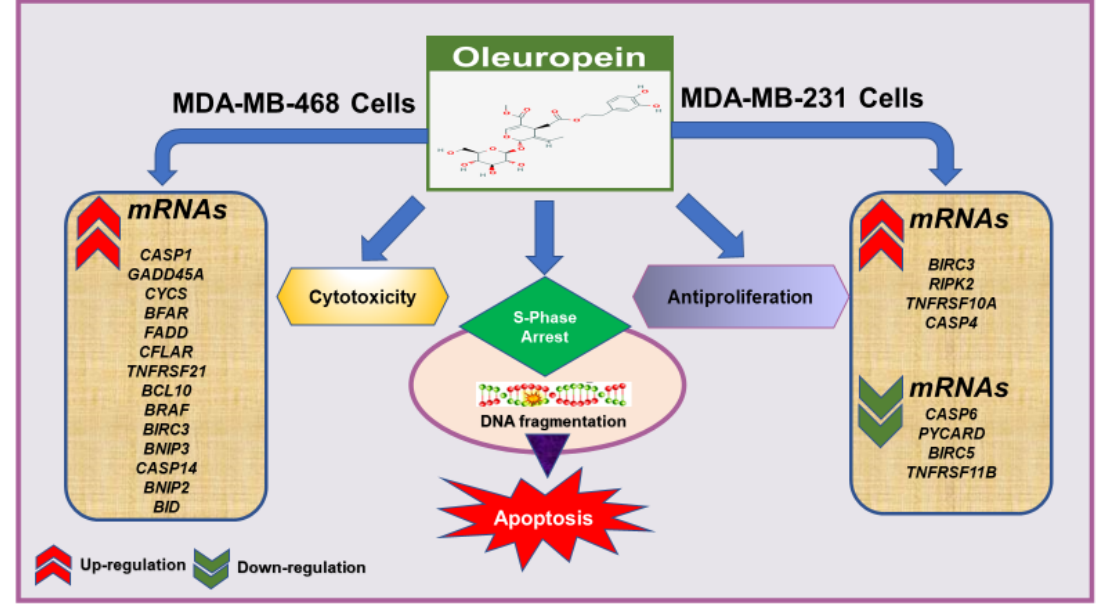
Figure 6. The e ff ect of OL in MDA-MB-231 and MDA-MB-468 TNBC Figure 6. The effect of OL in MDA-MB-231 and MDA-MB-468 TNBC cells.